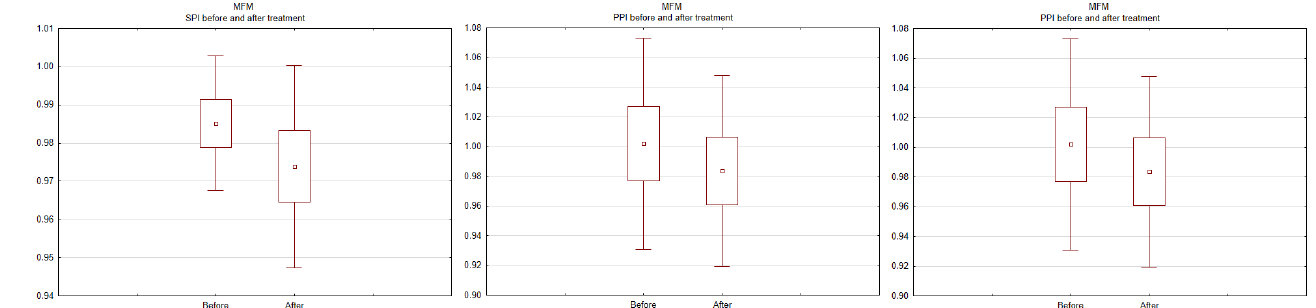
Figure 3. Systolic pressure index (SPI), diastolic pressure index (DPI), and pulse pressure index (PPI) at baseline and after implantation of the multilayer flow modulator. The mean SPI, DPI, and PPI values after the procedure were as follows: 0.60 ± 0.13, 0.95 ± 0.16, and 0.33 ± 0.17, respectively, for the BEVAR group, and 1.00 ± 0.03, 0.98 ± 0.12, and 1.04 ± 0.04, respectively, for the MFM group.